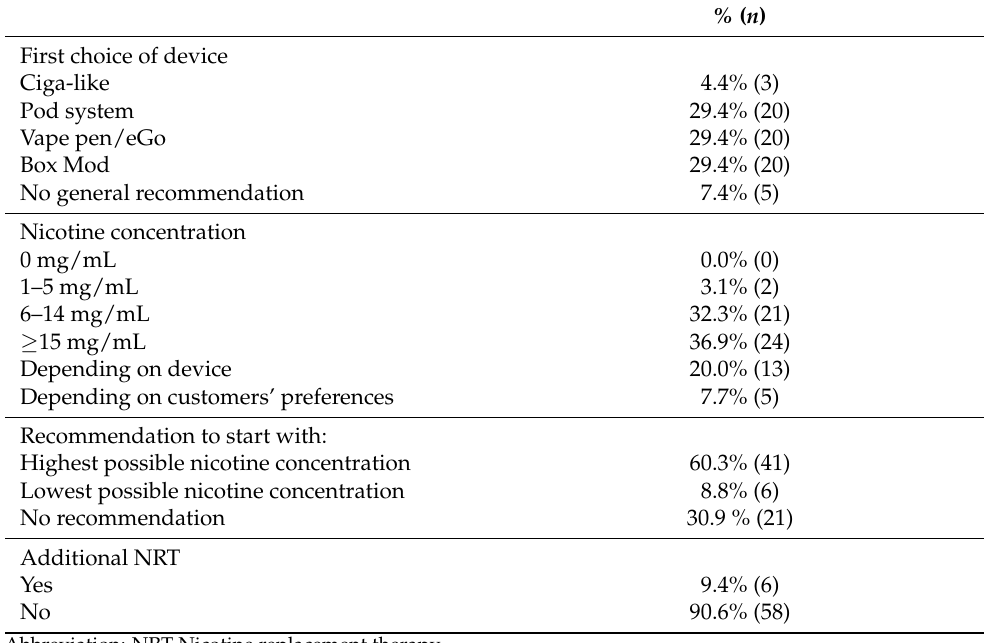
Table 2. Results of Case Vignette One (recommendations to a current smoker with high nicotine dependence interested in